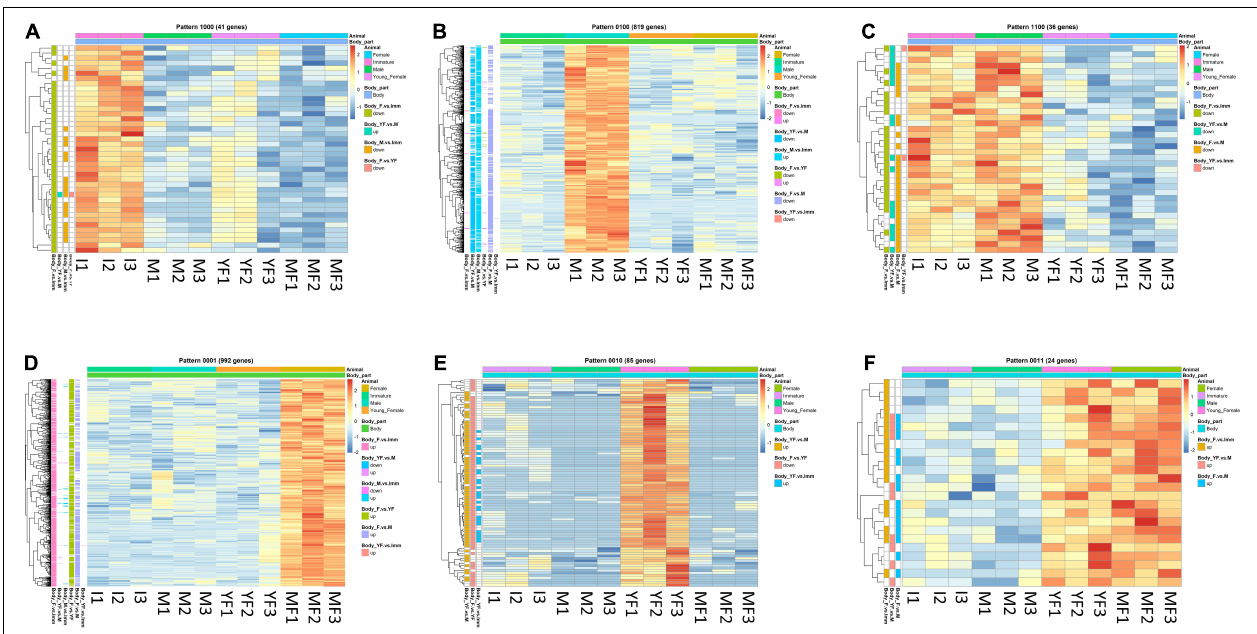
FIGURE 4 | Typical binary patterns of expression in the transcriptomic library of the Hippolyte inermis body. Genes that were differentially expressed (DE; FDR P < 0.05, linear fold change < − 1.3 or > 1.3) between any stages were unified and subjected to binary pattern analysis in which 1 = high expression and 0 = low expression. (A) 1000 - immature specific pattern. (B) 0100 - male specific pattern. (C) 1100 - immature and male specific pattern. (D) 0001 - mature female specific pattern. (E) 0010 - young female specific pattern. (F) 0011 - young female and mature female specific pattern. I = immature, M = male, YF = young female, MF = mature female. A list of all DE genes that matched any binary pattern can be found in Supplementary Table 1 .